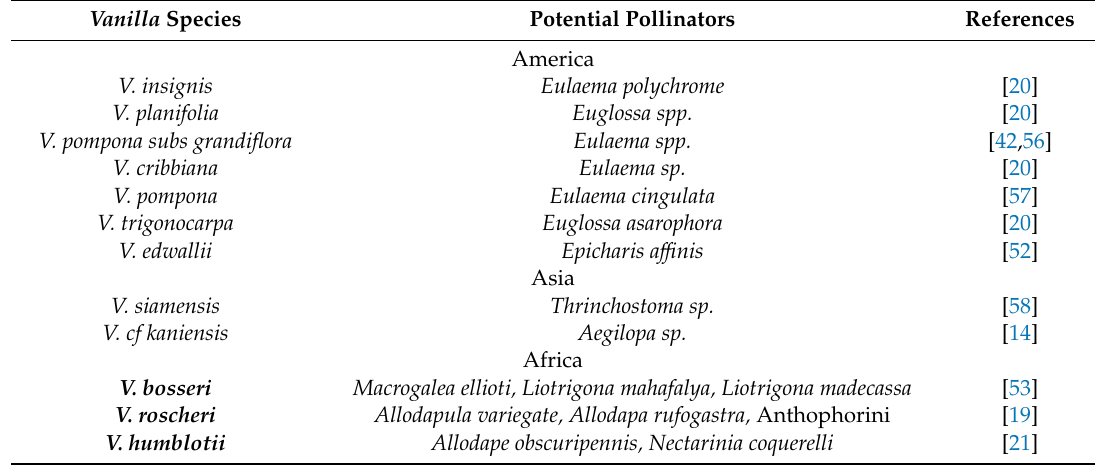
Table 2. Potential pollinators of some Vanilla species. Leafless species are highlighted in